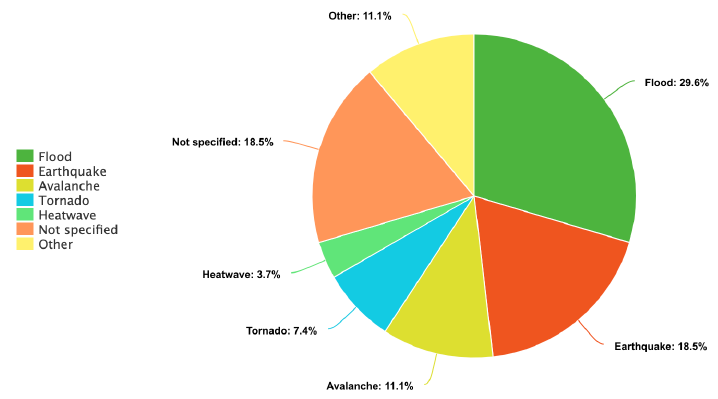
Figure 2. Numbers of included studies by type of disaster. Source: